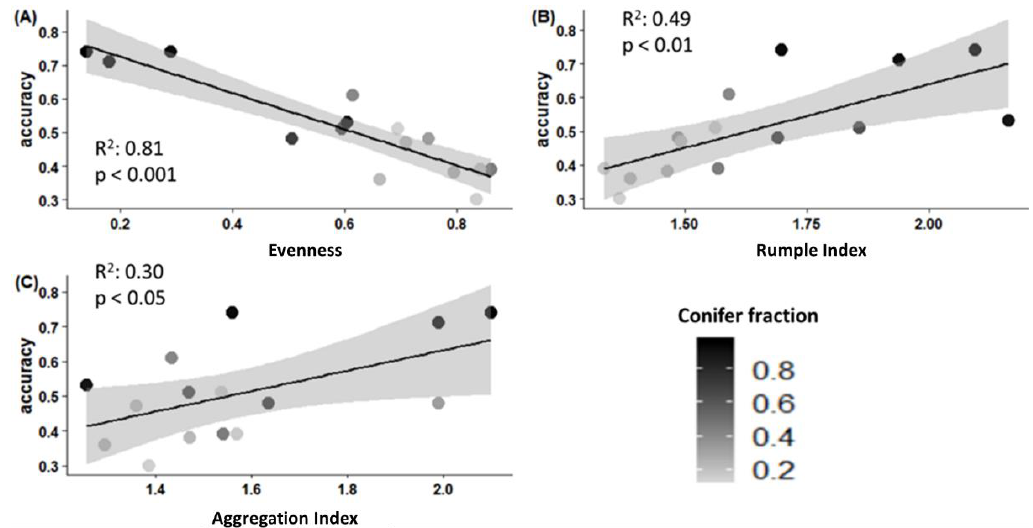
Figure 5. Prediction accuracy in relation to plot-level ( a ) evenness, ( b ) rumple index, and ( c ) aggregation index for one crown delineation method (DALPONTE). Points are colored to show fraction of conifer crown area per plot (conifer fraction). The relationship between accuracy and evenness was significant ( p < 0.05) across all methods. However, the relationship between accuracy and aggregation index was only significant for DALPONTE and SILVA, and the relationship between accuracy and rumple index was only significant for DALPONTE, SILVA and